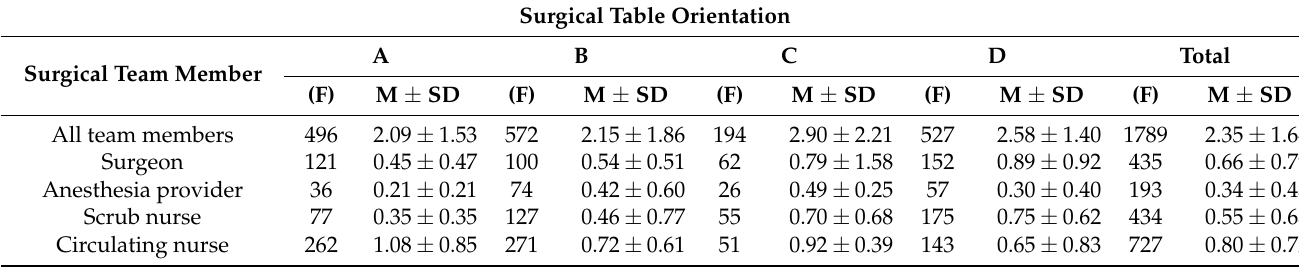
The Quasi-Poisson regression model predicting the number of contacts for each individual in the OR during the intraoperative phase is shown in Table 10. Individuals table in orientation C than the other surgical table orientations. Operating room 4 was associated with significantly less contacts than the other operating rooms (RR =